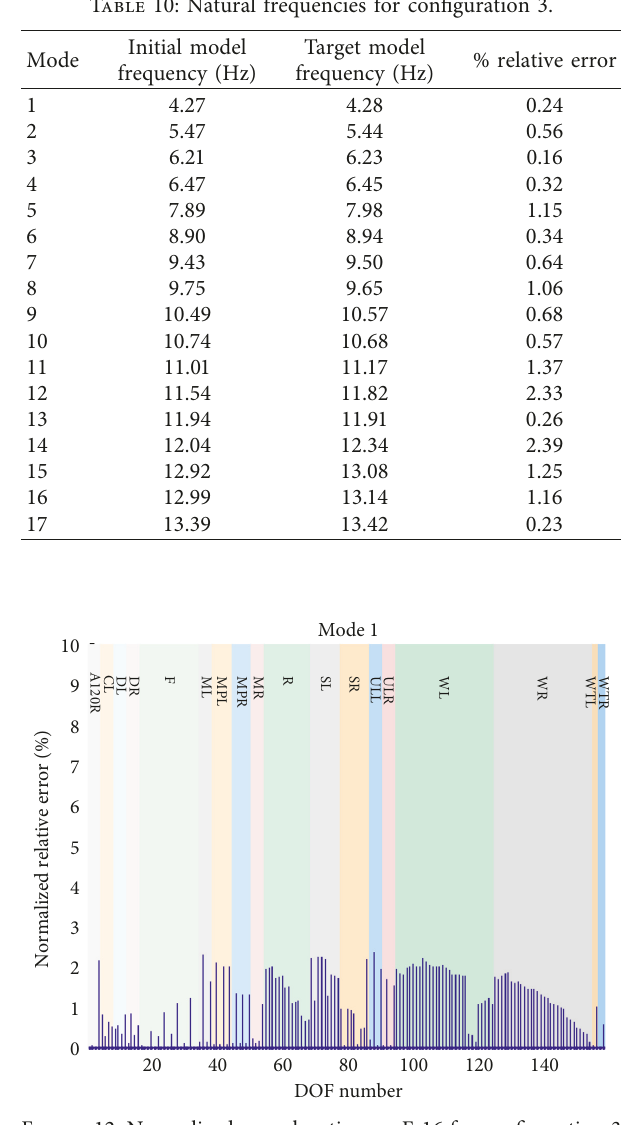
Figure 12: Normalized error location on F-16 for configuration 3 mode-1.